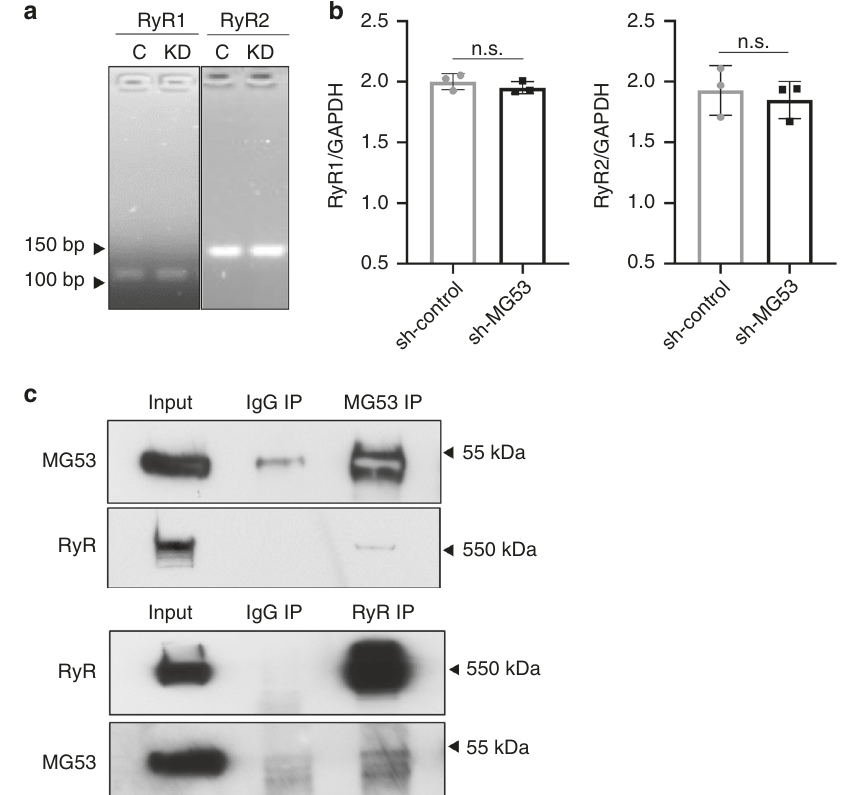
Fig. 6 MG53 associates with RyR. a Representative qPCR products of RyR1 and RyR2 from sh-control (lane labeled C) and sh-MG53 (lane labeled KD) THP1 cells (predicted amplicon size for RyR1 = 106 bp and RyR2 = 155 bp). b Quanti fi cation of RyR1 and RyR2 mRNA in sh-control and sh-MG53 cells shows no signi fi cant difference (data representative of three independent experiments each performed in triplicate; mean ± SD; n.s. means nonsigni fi cant; two-sided unpaired t tests). c Murine skeletal muscle lysates were used for co-immunoprecipitation (IP) assay. IP with MG53 antibody pulled down RyR1 (top). Conversely, IP with RyR antibody pulled down MG53 (bottom). Data are representative of four independent